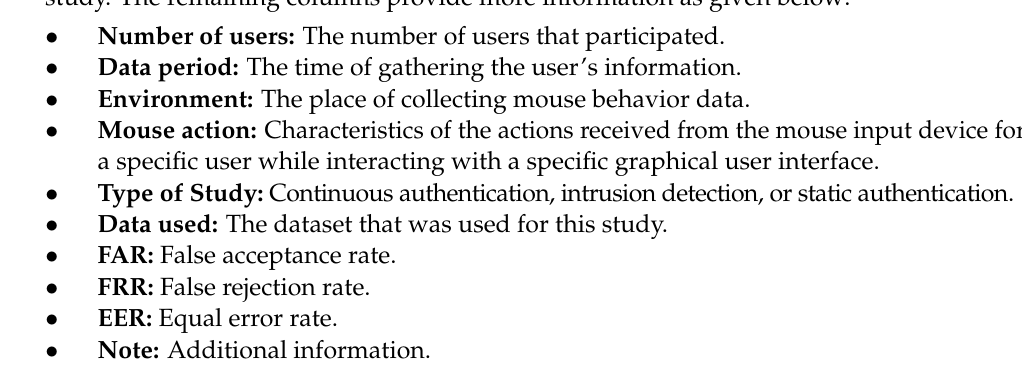
Table 1. Previous characteristics of the most important existing